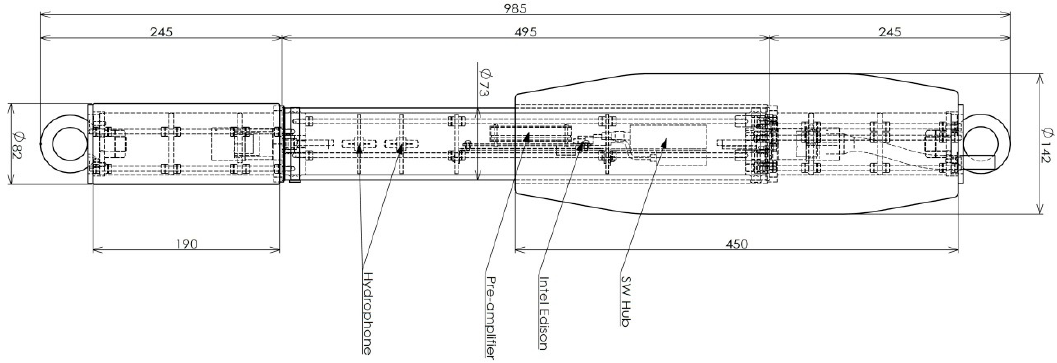
Figure 5. Schematic diagram of the single acoustic